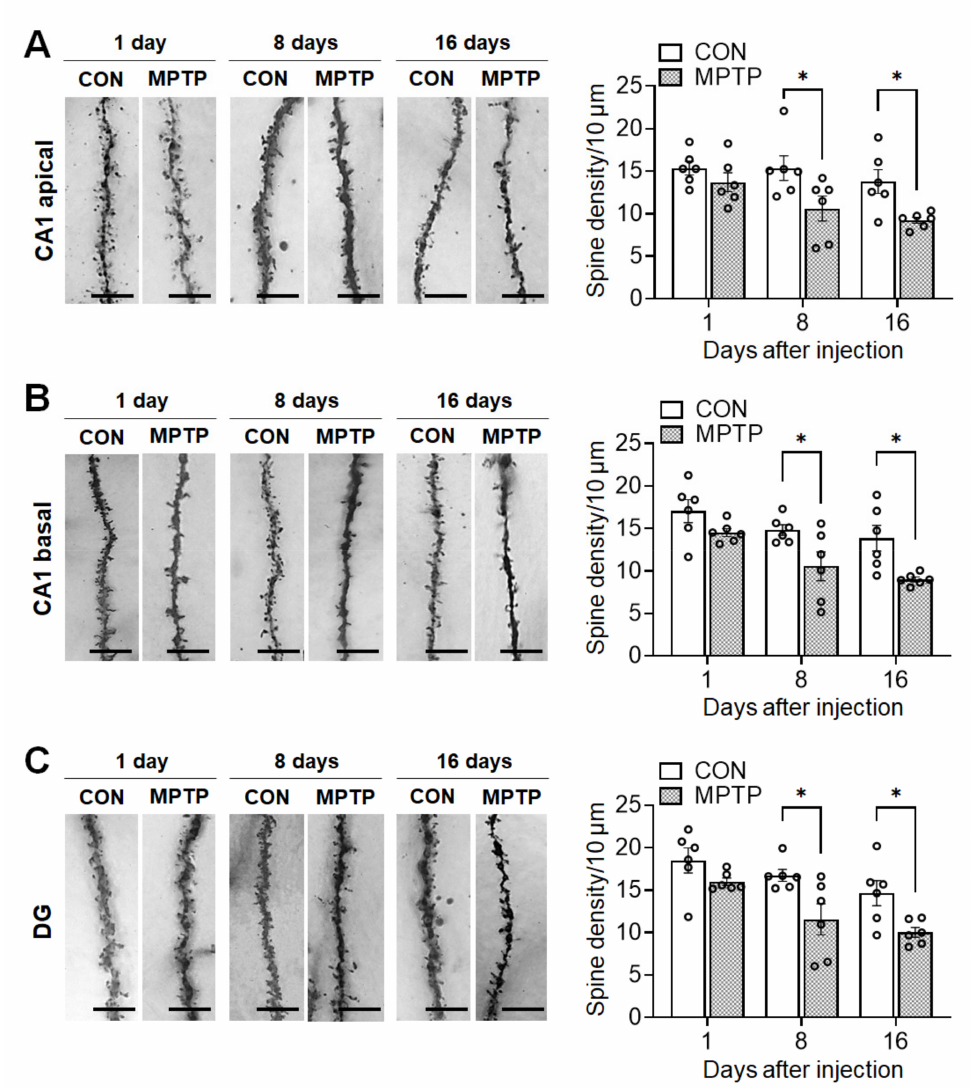
Figure 5. Acute MPTP treatment altered dendritic spine density in the hippocampus. Representative images from each group display dendritic spines along Golgi-impregnated neurons in cornu ammonis 1 (CA1) apical dendrites ( A , left panel), a CA1 basal dendrites ( B , left panel) and dentate gyrus (DG) dendrites ( C , left panel). Bar graphs ( A – C , right panel) display the spine density per 10 µ m of dendrite. Data are expressed as the mean ± standard error ( n = 6 mice/group). * p < 0.05 between the control (CON) and MPTP-treated groups. The scale bars in the dendritic images represent 5 µ